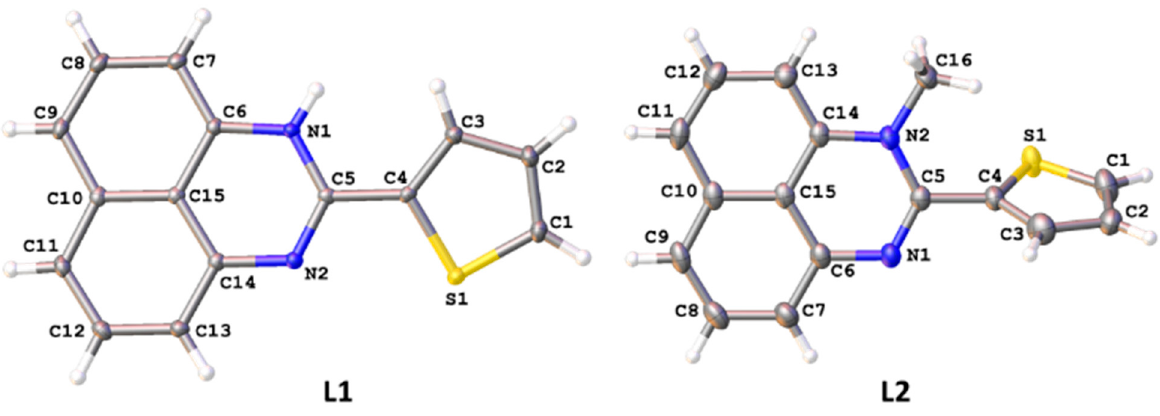
Figure 2. Molecular structures of L1 and L2 . Displacement ellipsoids are drawn at the 50% probability level.